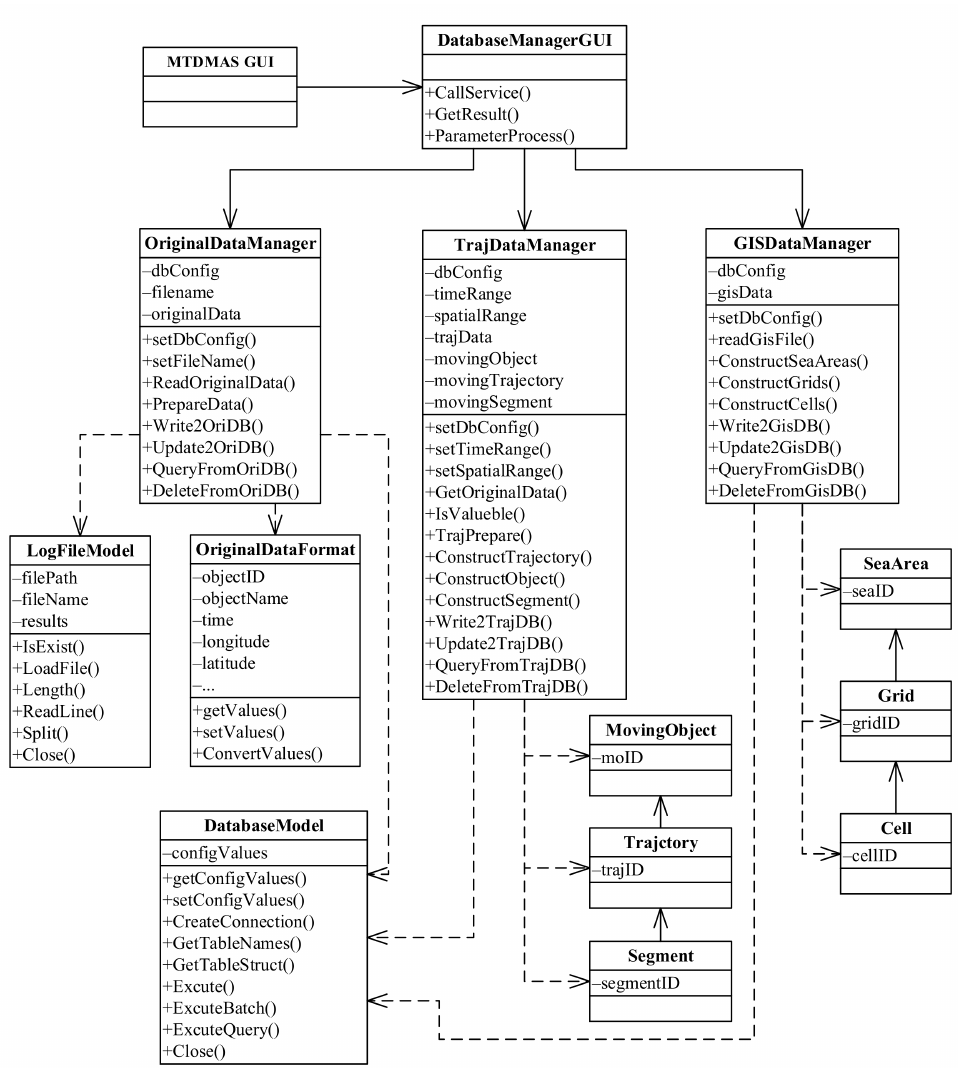
Figure 4. Class diagram of the database management